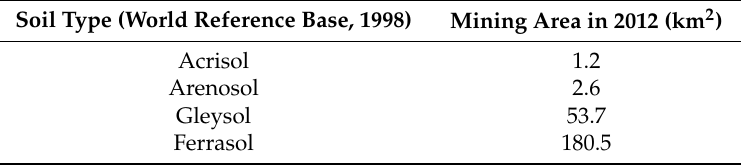
Table 4. Tabulated mining area in 2012 over different soil types according the international classification [32].